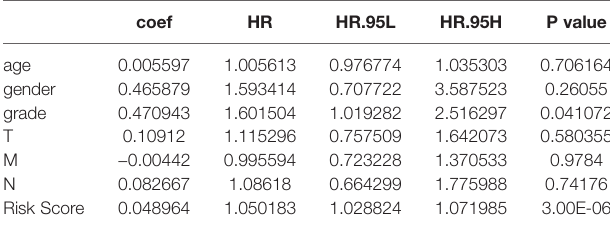
TABLE 4 | The clinical classi fi er and risk score in multivariate Cox